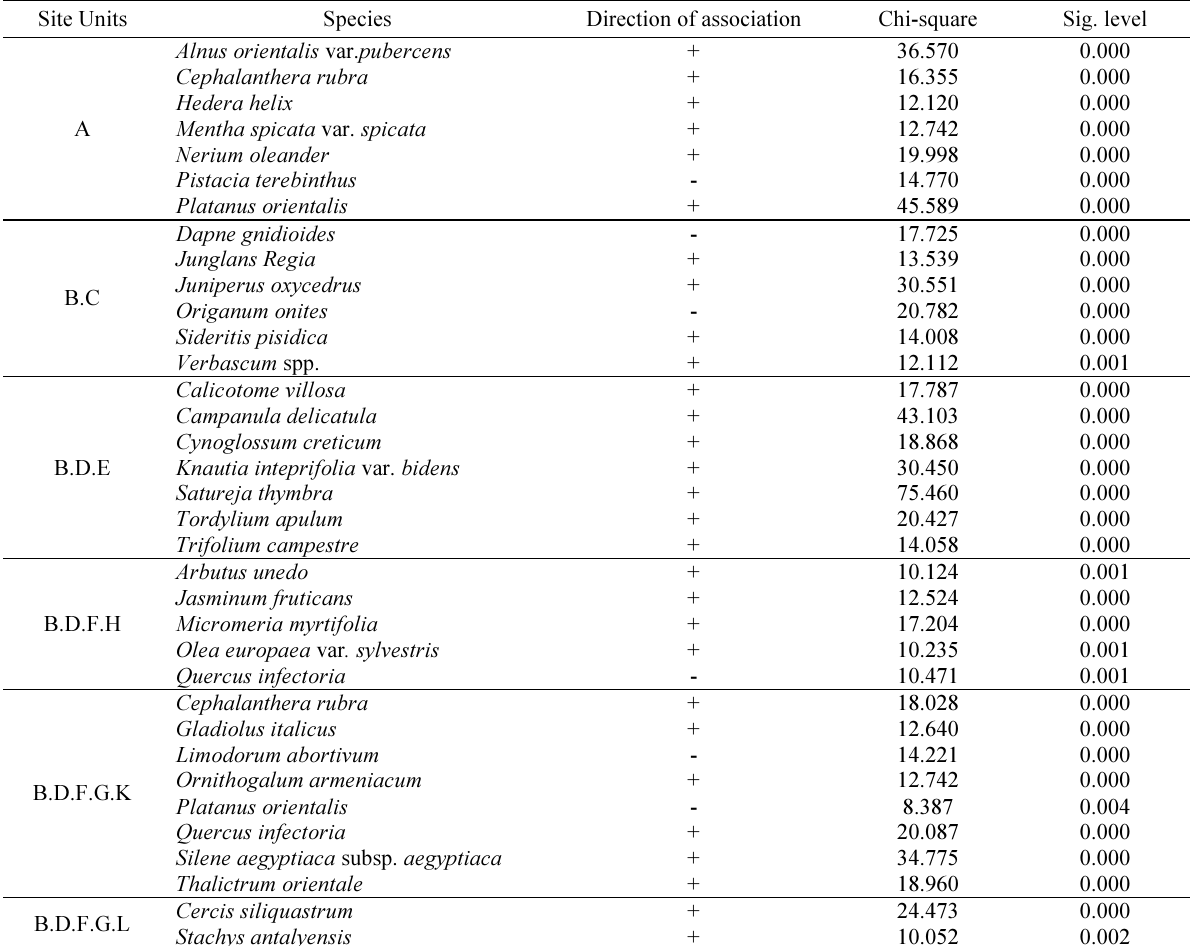
Table 4. Indicator species of the sites based on interspecific correlation analysis Site